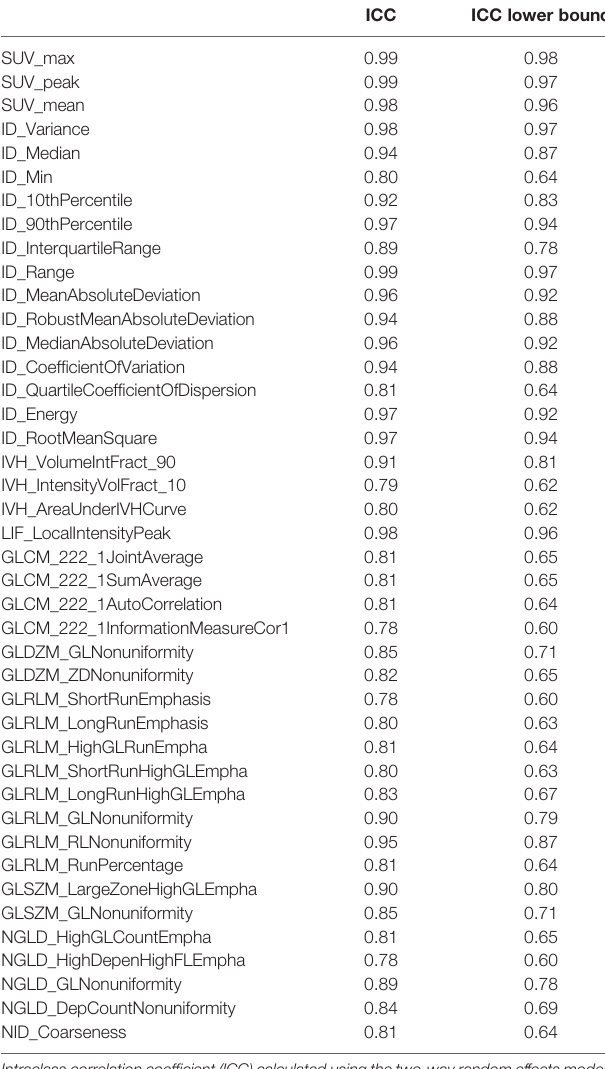
TABLE 3 | SUV statistics and robustness of textural features robust against contour delineation.